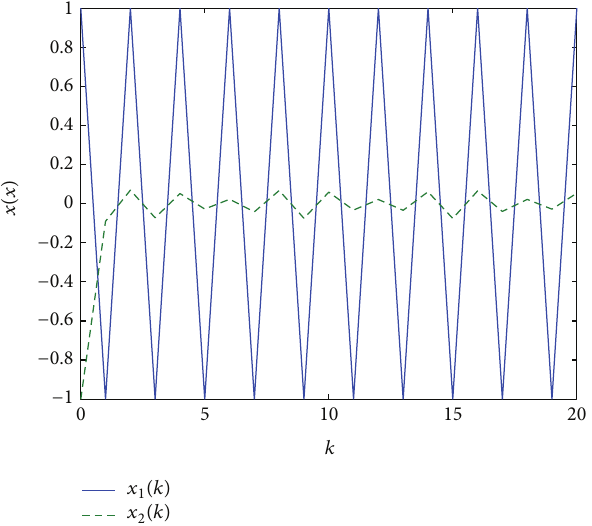
Figure 2: The state response of subsystem 2.